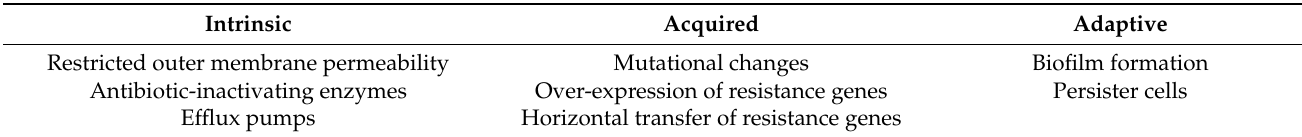
Table 1. Mechanisms of antimicrobial resistance in P. aeruginosa.